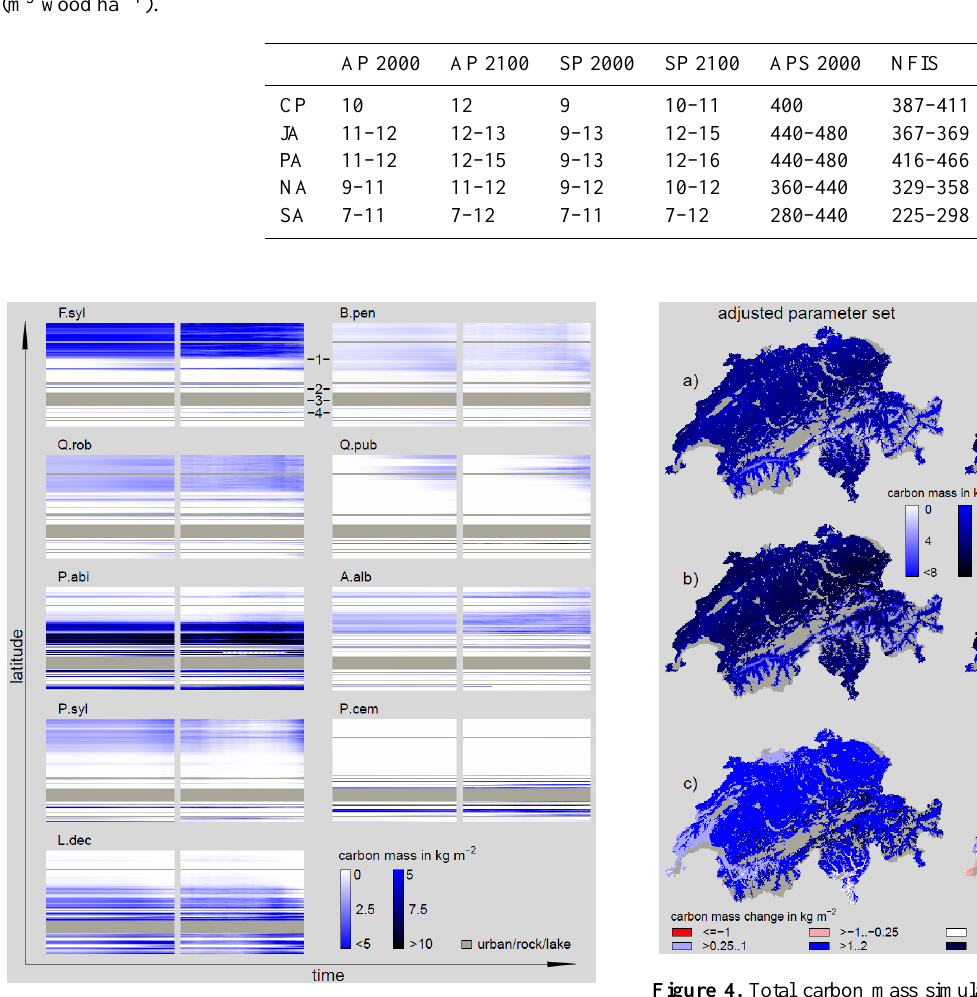
Figure 3. Carbon mass development along the analyzed transect of nine selected species using the stochastic (100 replicates) LPJ- GUESS approach (right) and the GAPPARD method (left), both with the adjusted parameter set. The timescale on each plot extends from 1900 (left side) to 2100 (right side). A.alb: Abies alba ; B.pen: